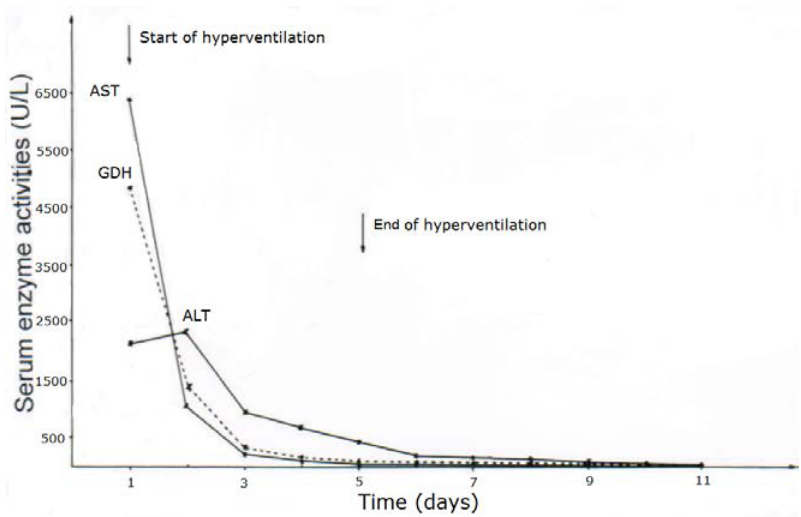
Figure 4. Patient 13 with CCl 4 intoxication by inhalation (unknown amounts) and serum activities of AST, ALT, and GDH following poisoning and under CO 2 -induced hyperventilation therapy.